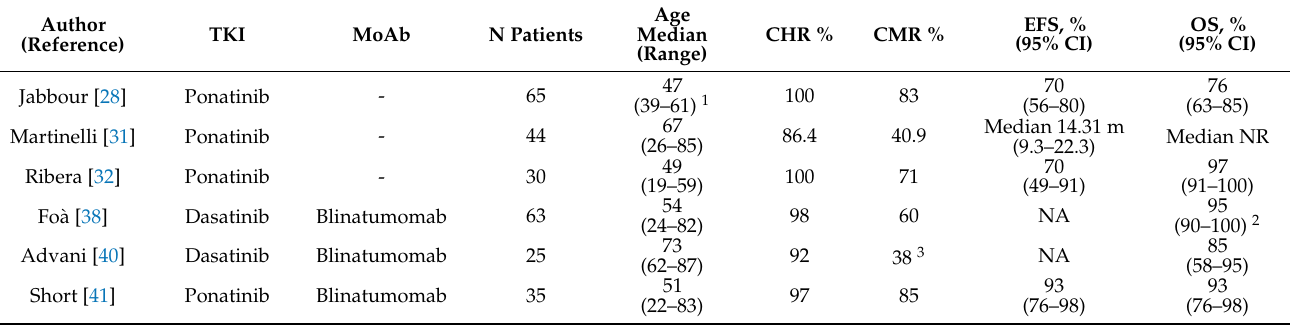
Table 1. Main results of trials including third generation TKI (ponatinib) or immunotherapy (blinatu- momab) in newly diagnosed patients with Ph+